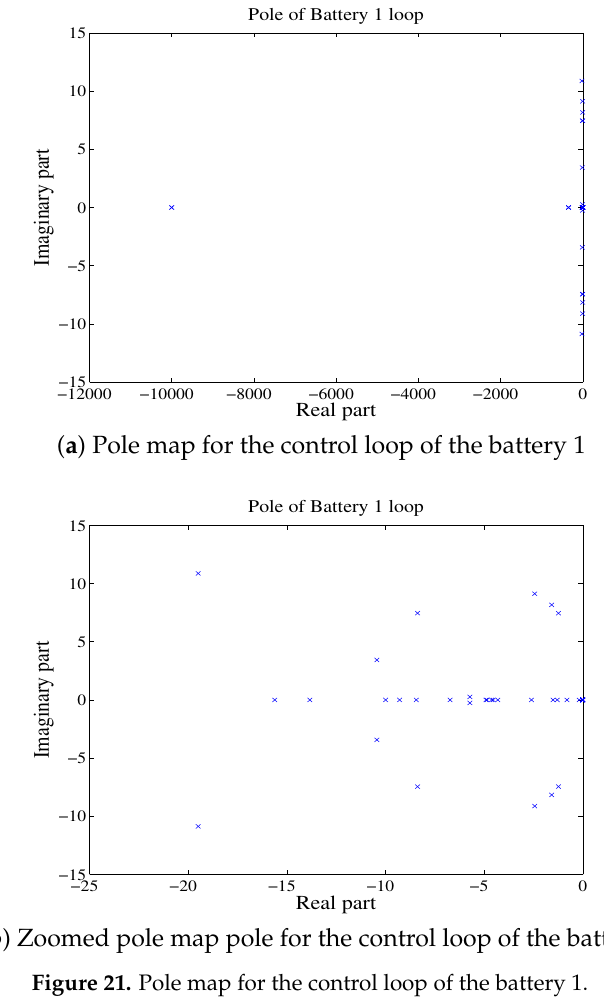
Figure 21. Pole map for the control loop of the battery